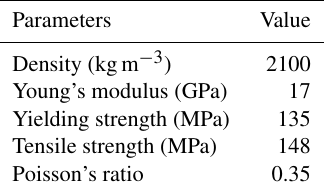
Figure 1. Images of PTF with different configuration.